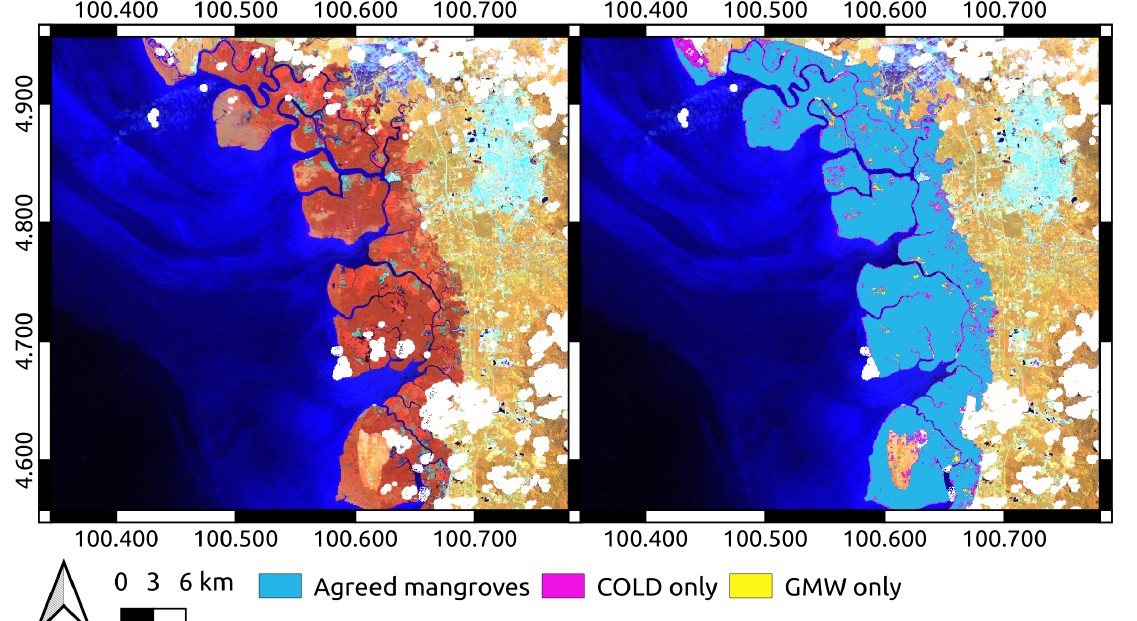
Figure 10. Example classification of mangroves in the Matang Forest Reserve, Malaysia. Left: false colour Landsat 5 image from May 2009 where Red = NIR, Green = SWIR1, and Blue = Red. Right: classification showing the high level of agreement between COLD and the GMW for this region. COLD has captured mangroves in the top left of the area which were missed by the